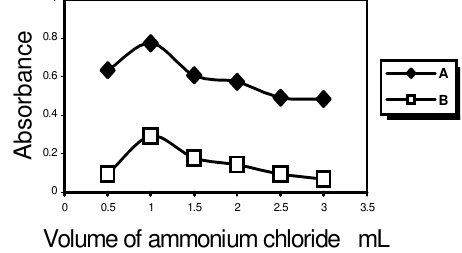
Figure 4. Effect of the volume of ammonium chloride solution on the reaction between fast red B salt and (A) secnidazole 12.5 µg.mL -1 and (B) niclosamide 6.25 µg.mL -1